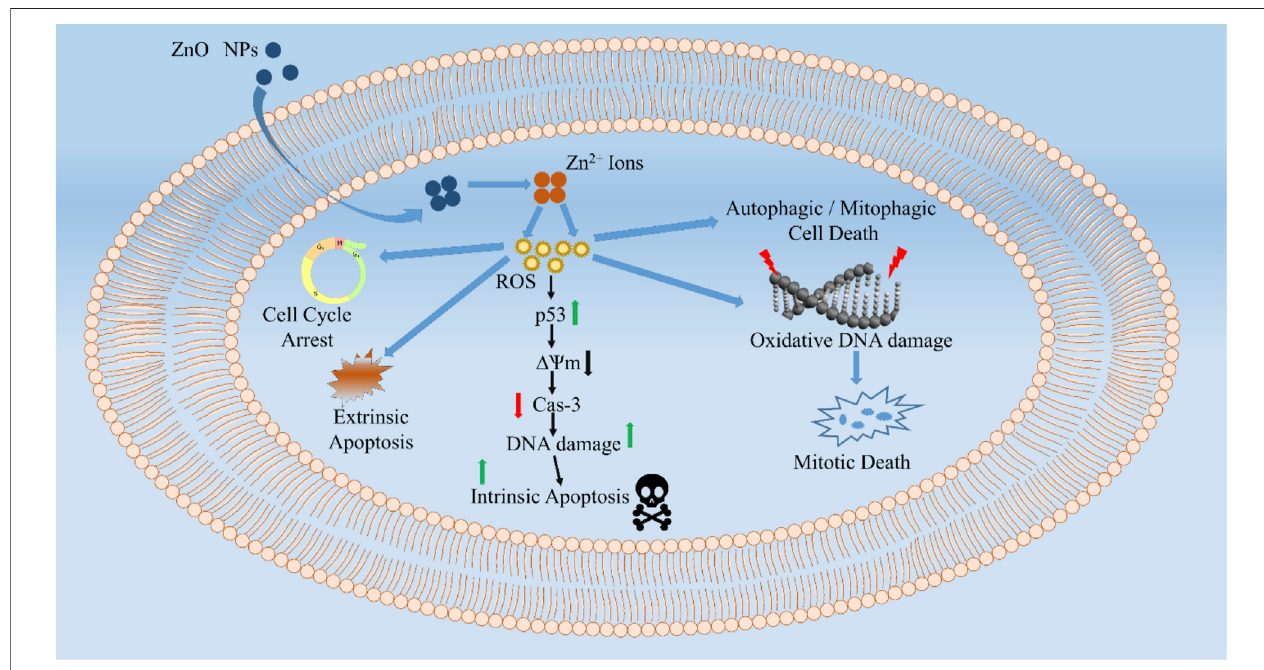
FIGURE 3 | Anticancer effect of zinc